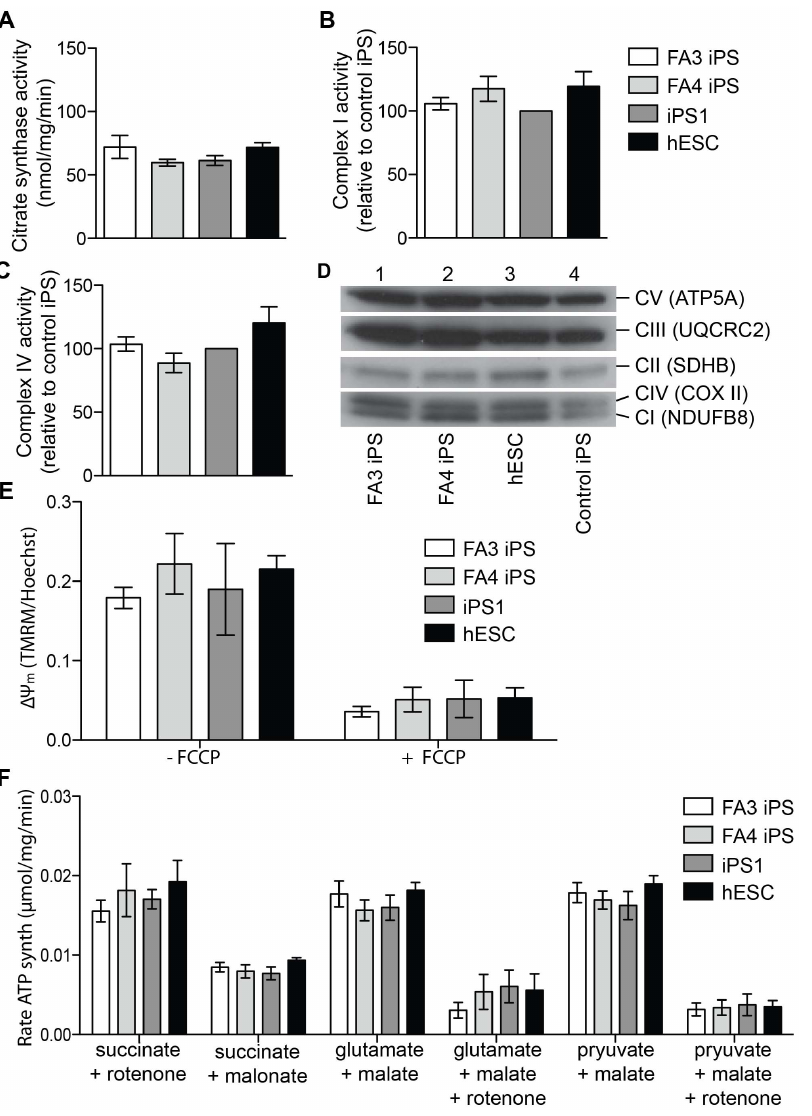
Figure 4. Mitochondrial functional analyses of FA iPS neural progenitors and neurons. ( A ) Citrate synthase activity was measured in neurosphere lysates spectrophotometrically and expressed relative to total protein. ( B ) CI, and ( C ) CIV activities were measured in neurosphere lysates by immuno-capture dipsticks, and expressed relative to control iPS1. ( D ) Expression of subunits representative of the OXPHOS CI-V was determined in neurosphere lysates by western blot analysis. ( E ) The DY m was assessed in dissociated neurospheres plated as a monolayer by measuring the accumulation of the cationic dye TMRM relative to cell number (as determined by Hoechst staining). ( F ) The rate of ATP synthesis was measured in digitonin permeabilised neurospheres, with indicated substrate inhibitor combinations. Error bars are SEM. N=3–5 experiments, with at least 12 neurospheres per condition for each replicate experiment.